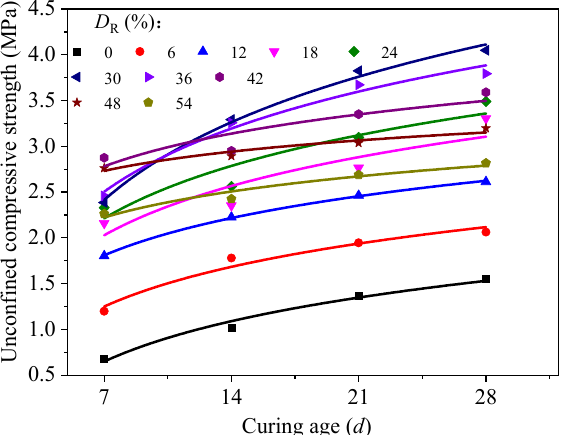
Figure 9. Relationship between unconfined compressive strength and curing age. Table 6. Parameters of unconfined compressive strength with the curing age. Red Mud Dosage ( D R